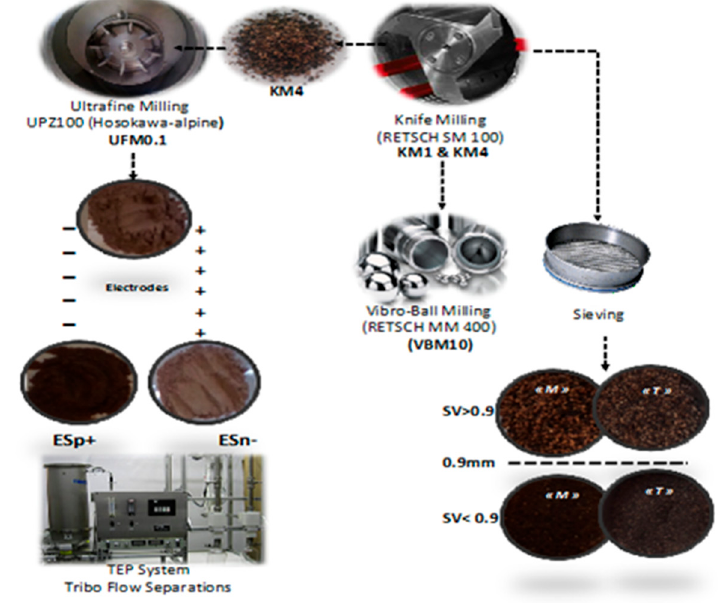
Figure 6. Mechanical pretreatments and fractions studied.